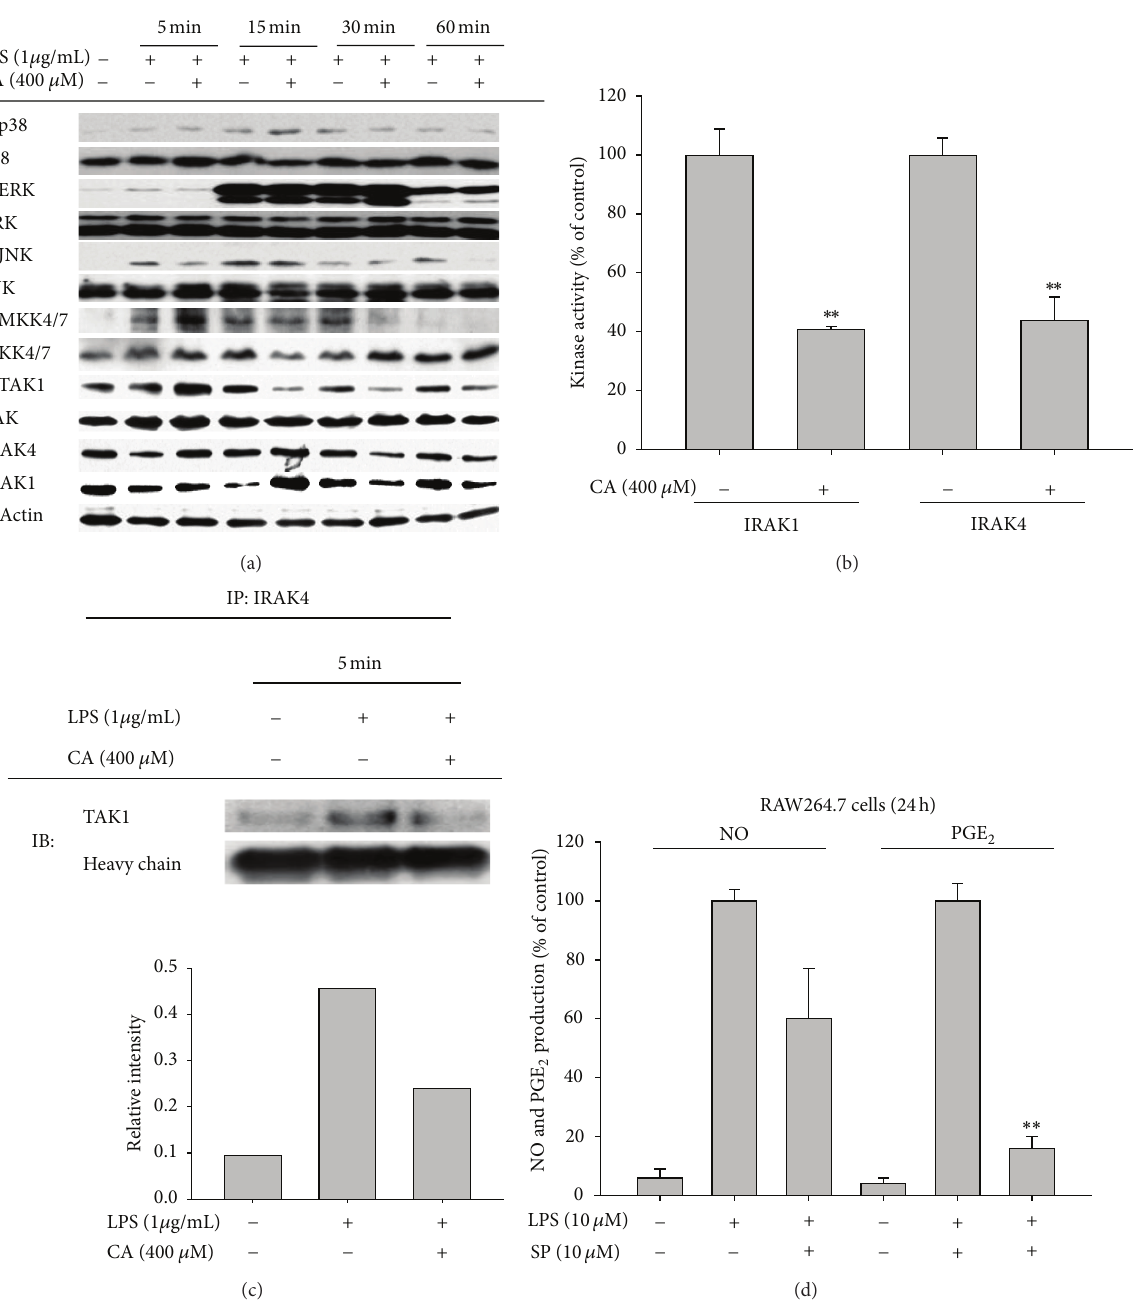
Figure 4: Effect of CA on the activation of AP-1 upstream signaling. (a) Levels of total or phosphoforms of MAPK (JNK, p38, and ERK) and JNK upstream enzymes (MKK4/7, TAK1, IRAK4, and IRAK1) from total lysates were determined by immunoblotting analyses with specific antibodies. (b) IRAK1 and IRAK4 kinase activities were determined by direct kinase assays with purified enzymes. The control for each enzyme (IRAK1 or IRAK4) was the activity obtained with vehicle treatment alone and was set at 100%. ∗ 𝑃 < 0.05 and ∗∗ 𝑃 < 0.01 , compared to the control. (c) RAW264.7 cells (5 × 10 6 cells/mL) were incubated with CA (400 𝜇 M) in the presence or absence of LPS (1 𝜇 g/mL) for 5 min. After preparing total lysates, the level of TAK1 binding to IRAK4 was identified by immunoprecipitation with an IRAK4 antibody and immunoblotting with antibodies against the rabbit immunoglobulin heavy chain and TAK1. (d) Culture supernatants prepared from LPS-treated RAW264.7 cells that were pretreated with a standard JNK inhibitor (SP600125 (SP)) were assayed for NO and PGE 2 . HC: heavy chain; ∗∗ 𝑃 < 0.01 , compared to the